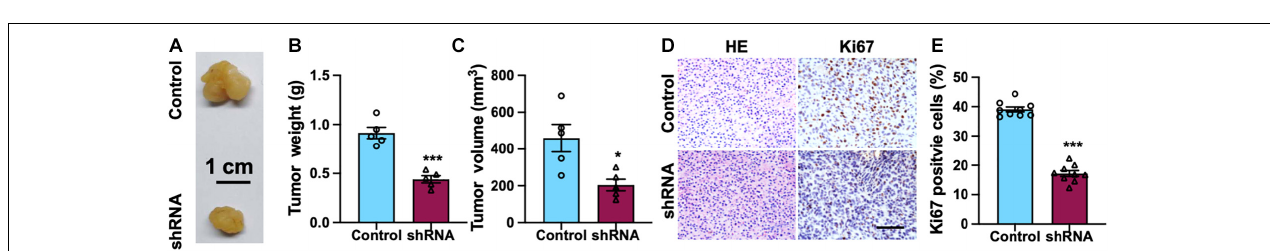
FIGURE 4 | SH2B3 promotes TMZ-induced cellular apoptosis in vitro . (A) U87 (left panel) and U251 (right panel) cells expressing with or without SH2B3 shRNA were treated with indicated concentrations of TMZ, and cell viability was determined by sulforhodamine B (SRB) assay. (B) U87 cells expressing with or without SH2B3 shRNA were treated with 50 µ M TMZ for 48 h, and living cells were assessed by fluorescence-activated cell sorting (FACS), and representative images were shown. (C) Quantification data of U87 ( B , up panel) and U251 cells (below panel). (D) Representative images of colony derived from indicated cells were treated with indicated concentrations of TMZ. (E) Quantification data for panel (D) . Control or shRNA means indicated cells expressing control shRNA or SH2B3 shRNA, respectively. *, **, and *** indicate p < 0.05, p < 0.01, and p < 0.0001, respectively.